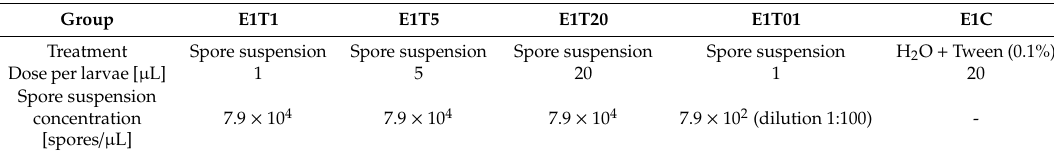
Table 1. Experiment 1: Directly pipetting Beauveria bassiana on the back of larvae. Group